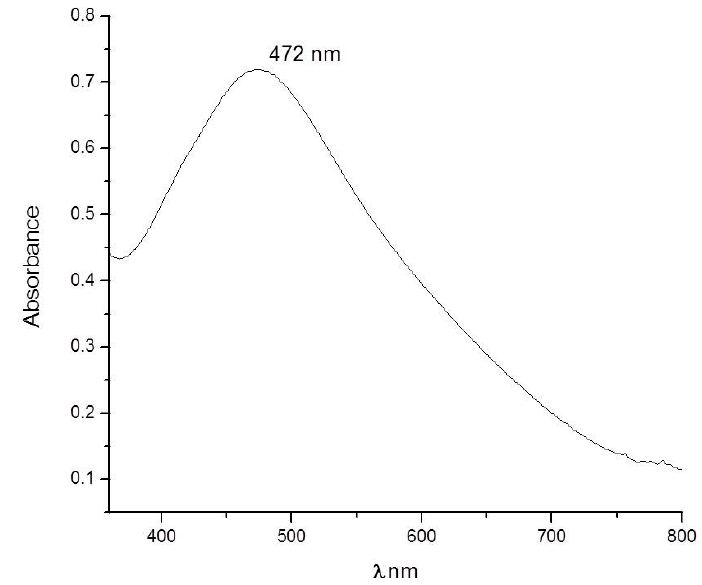
Figure 1. UV-Vis spectra of Ag-NPs obtained with Heterotheca Inuloides .